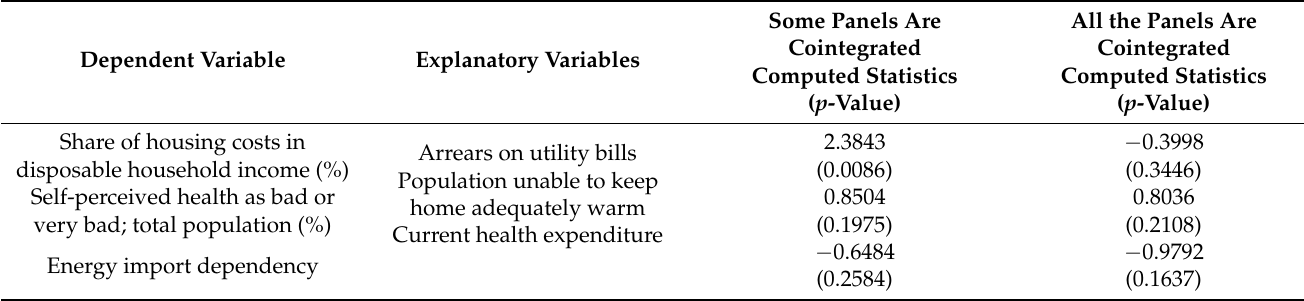
Table 4. The Westerlund test for